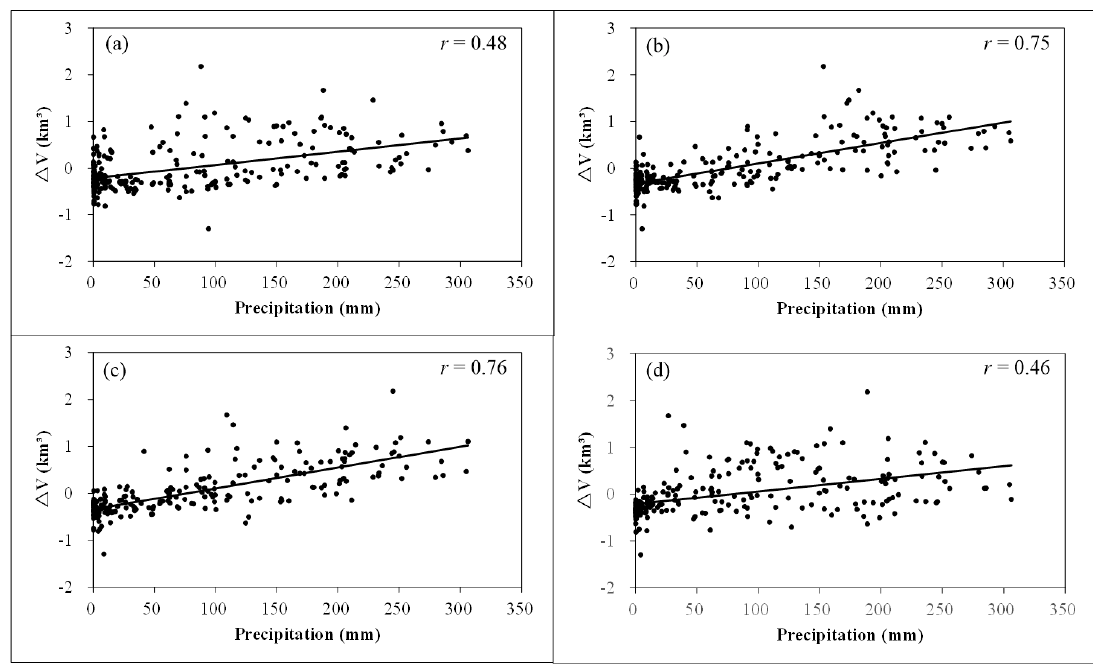
Figure 18. Correlations between ∆V and precipitation of: the same month ( a ); the prior month ( b ); the second month prior to the same ( c ); and the third month prior to the same ( d ).